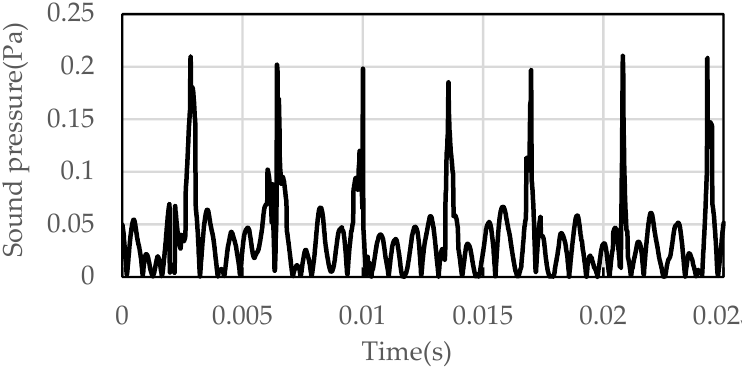
Figure 12. Experimental results of fan noise in the time domain.